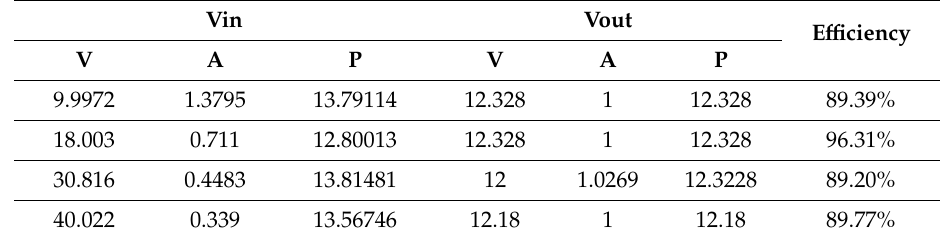
Table 3. Measured data of circuit.